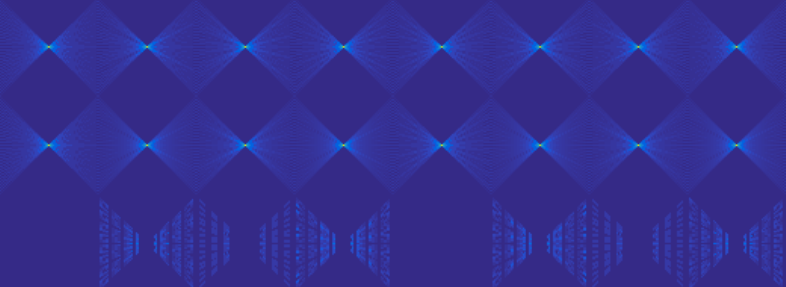
Figure 12. Top row, 8 horizontal half-impulse responses on a 32 × 32 problem. Middle row, there are only 4 different half-impulse responses that approximate the original ones. They were obtained with k-means clustering. Bottom row, absolute difference between original and approximated half-impulse responses enhanced five times, to reveal the otherwise imperceptible error.